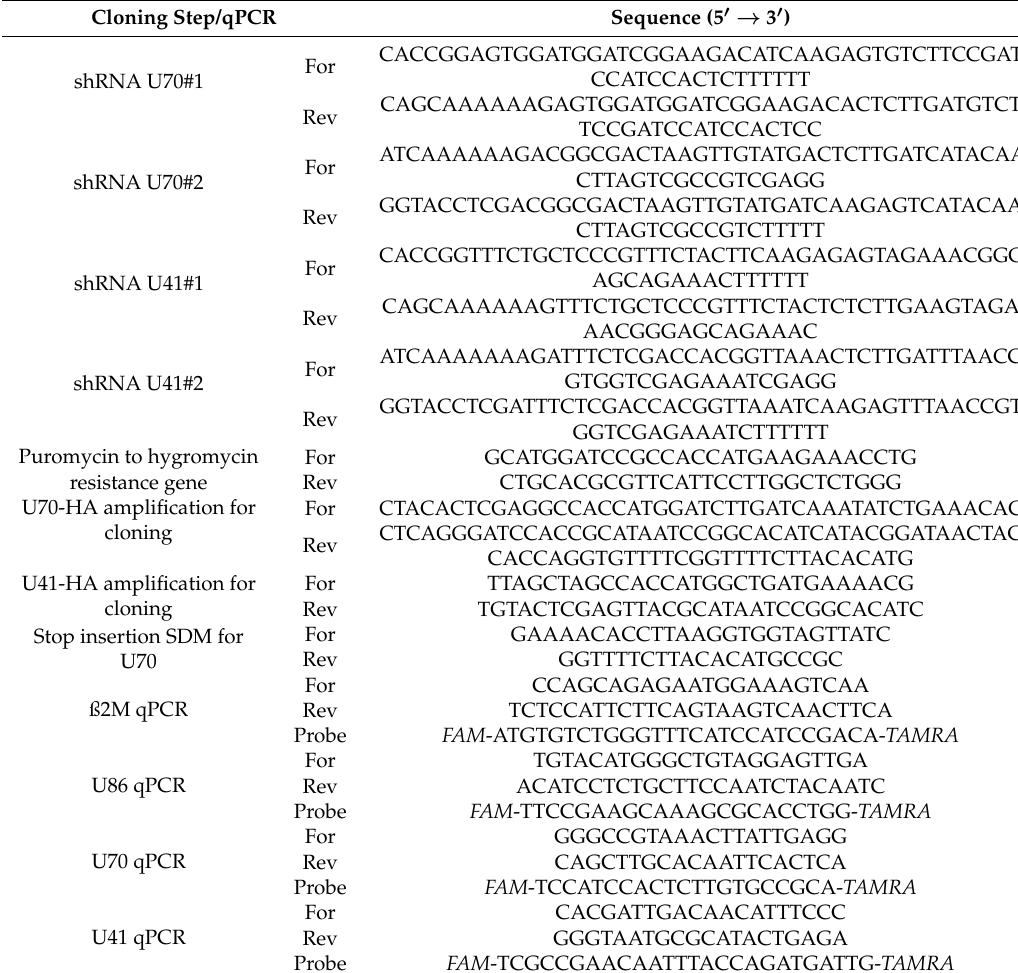
Table 1. Oligonucleotide sequences used in this